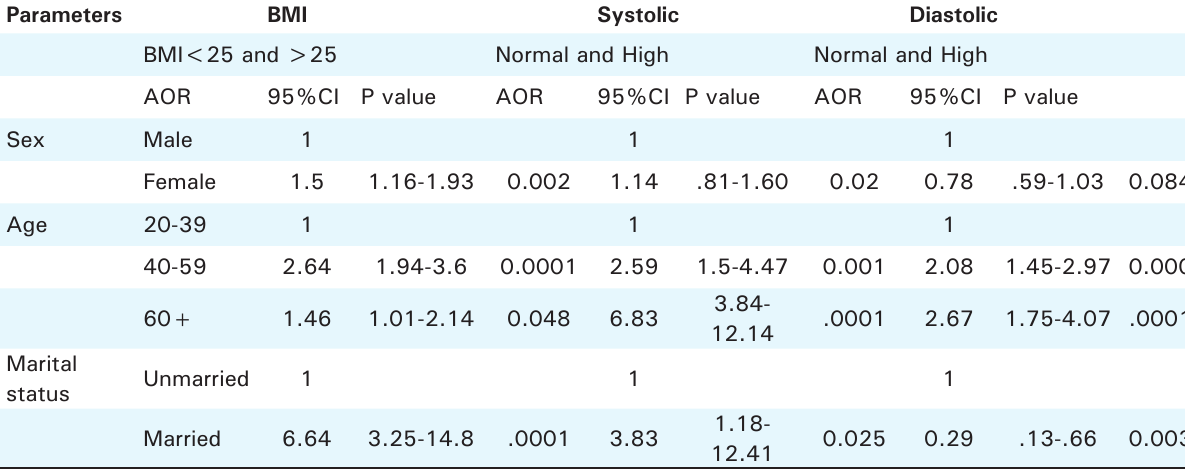
Table 5. Logistic regression analysis of demographic factors, Blood Pressure and